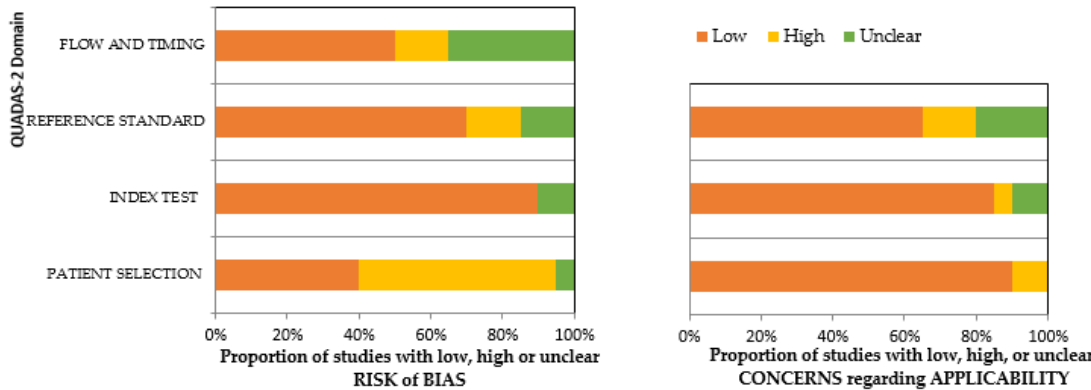
Figure 2. QUADAS ‐ 2 assessment of the individual risk of bias domains and applicability concerns. Figure 2. QUADAS-2 assessment of the individual risk of bias domains and applicability